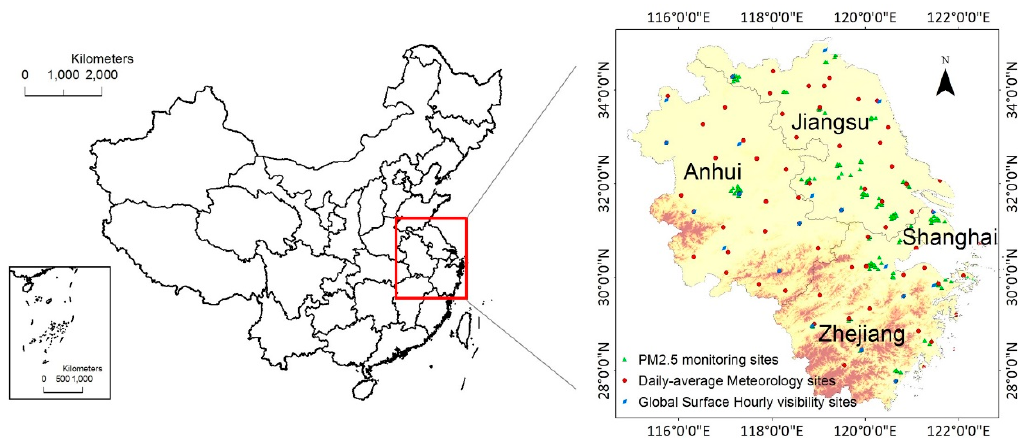
MODIS Terra satellite (i.e., approximately 10:30 a.m. at local time).